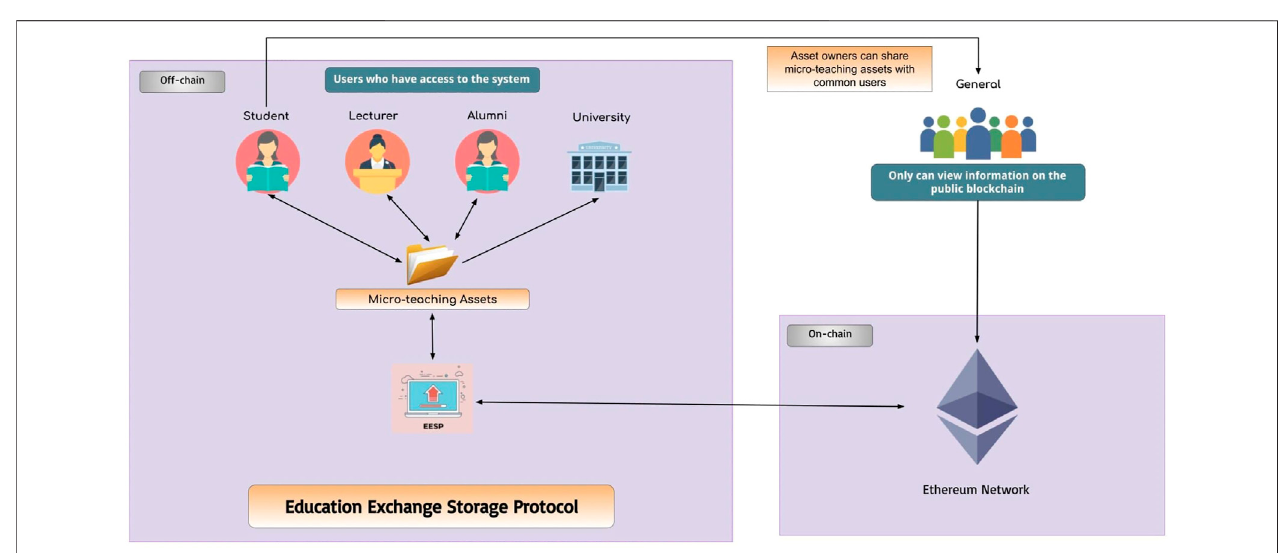
FIGURE 7 | EESP framework part 3.